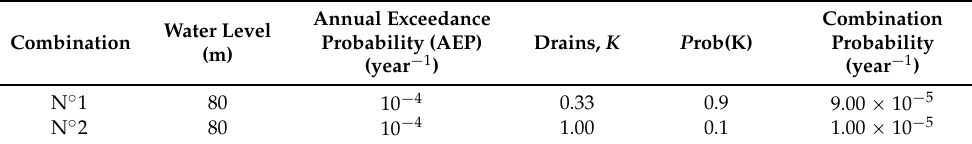
Table 2. Loading combinations and associated